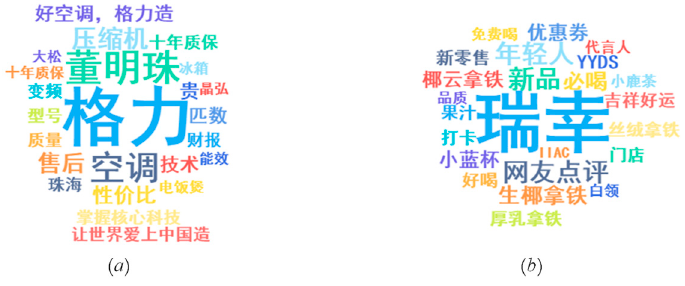
Figure 10. the Word Clouds of the Results of BI Evaluation Model Based on KG and Two-dimen- Figure 10. The Word Clouds of the Results of BI Evaluation Model Based on KG and Two‑dimensional sional Bag-of-words. ( a ) the Word Cloud of GREE Electric. ( b ) the Cord Cloud of Luckin Co ff ee. Bag‑of‑words. ( a ) the Word Cloud of GREE Electric. ( b ) the Cord Cloud of Luckin The English meaning of the Chinese words in the clouds are listed as follows: